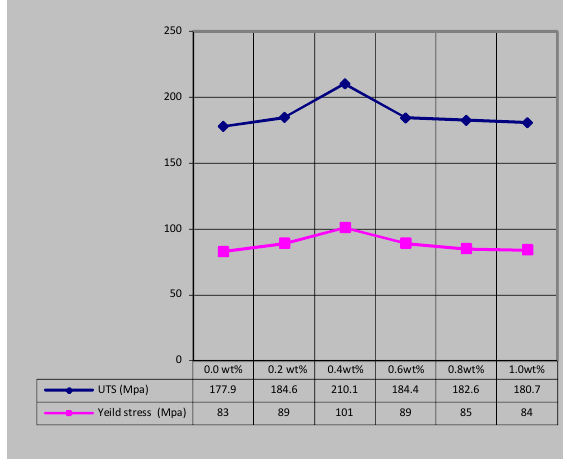
Fig. 2. UTS and Yeild stress against wt. % nanoparticles (Al 2 O 3 )